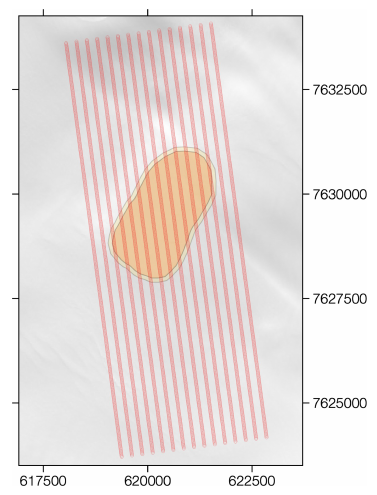
Figure A2. Lake 6 transects for photoclinometry calculations for the image on 28 October 2016 prior to drainage (red), lake extent (orange) and buffer (yellow). For a description of how these features are used in the photoclinometry calculations, see Methods.